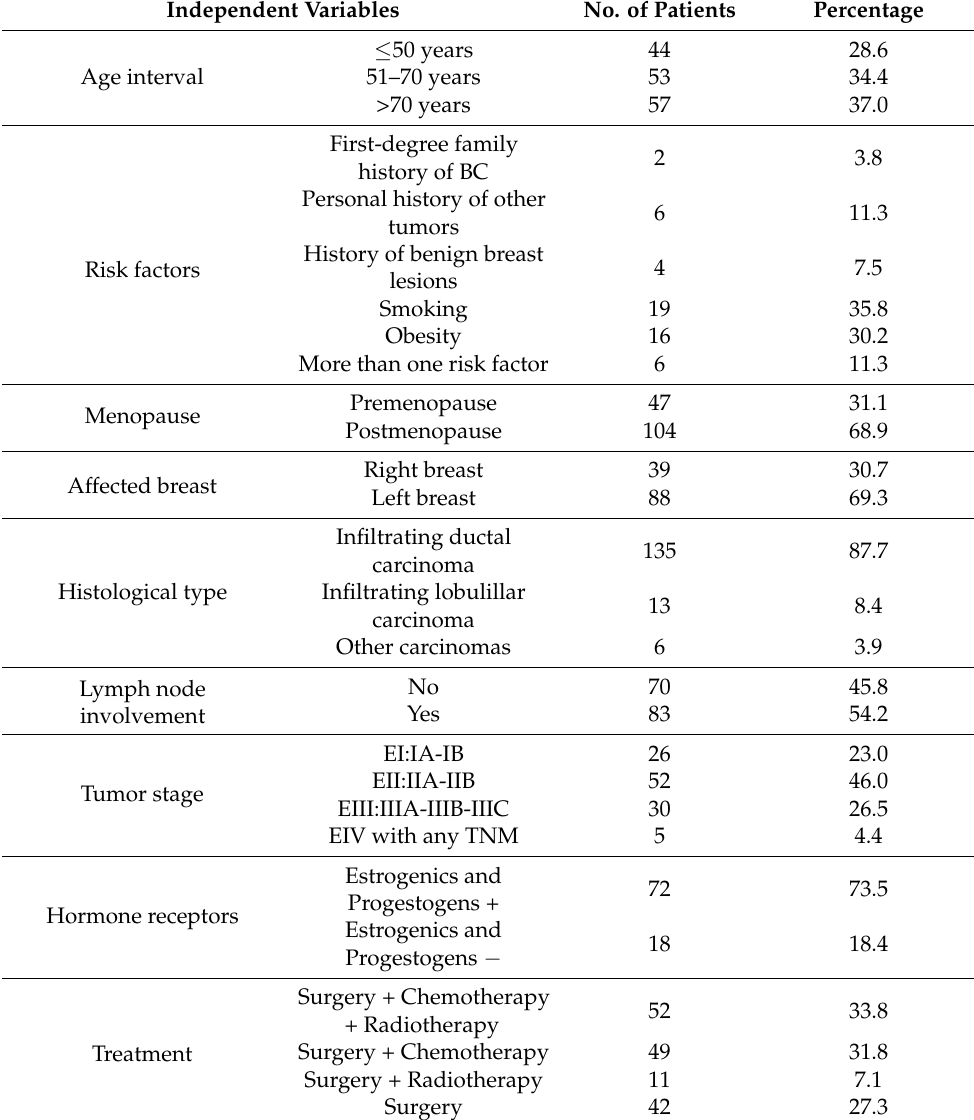
Table 1. Descriptive analysis of the study population